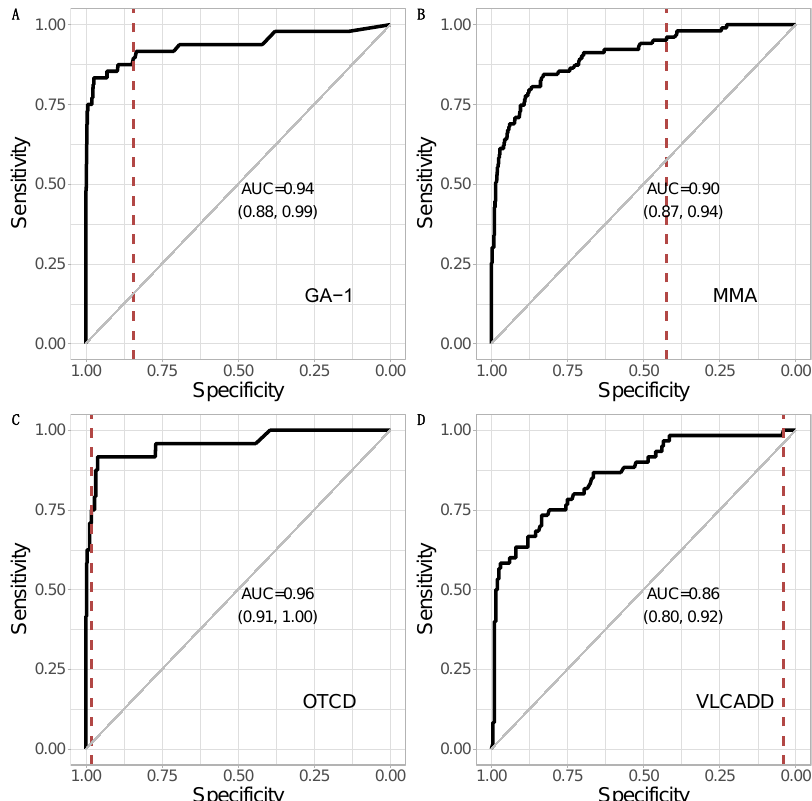
Figure 1. Analysis of newborn metabolic profiles with Random Forest (RF). Receiver operating characteristic (ROC) curve analysis for infants with and without a confirmed diagnosis using RF analysis of 39 MS/MS analytes. Without altering the sensitivity of primary newborn screening (NBS) for each of the four disorders, RF reduced the number of false-positive cases (vertical dotted line) by 89% for GA-1 ( A ), 45% for MMA ( B ), 98% for OTCD ( C ) and by 2% for VLCADD ( D ). For each disease, the number in parenthesis shows the 95% confidence interval of the area under the ROC curve (AUC).